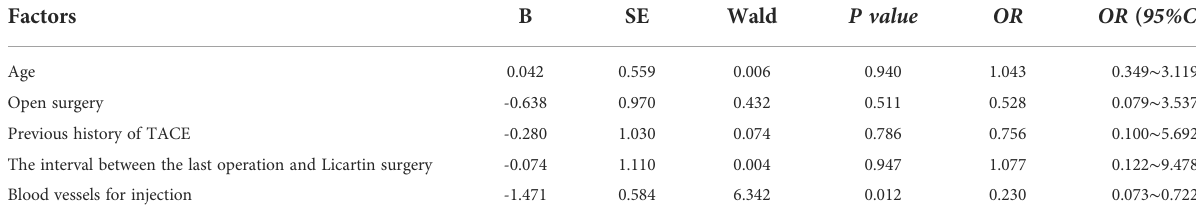
TABLE 4 Binary logistic regression analysis of factors resulting in the decreased Licartin distribution in hepatic carcinoma area compared with the normal liver tissue.